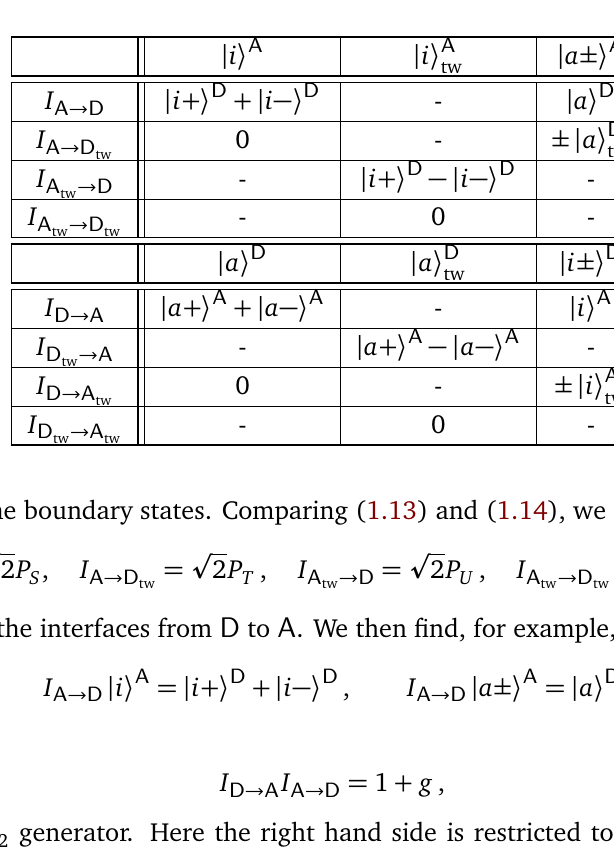
Table 1: Action of interface operators (between theories A and D ) on the boundary